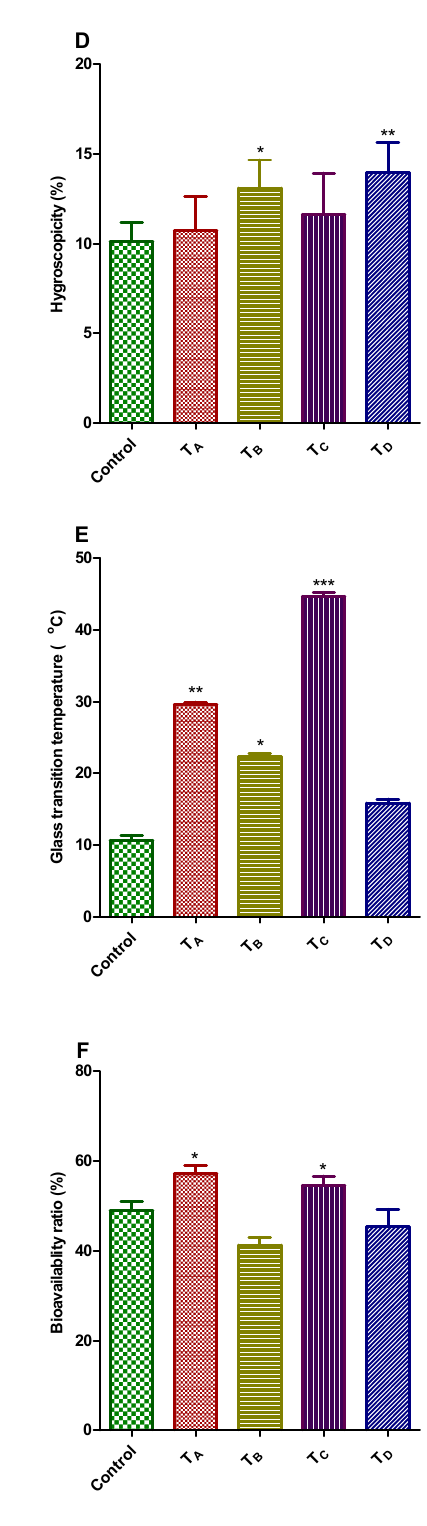
Figure 1. ( A – F ) Physical properties and bioavailability ratio (%) of PHF extract microencapsulated with GA, GE, MD and their combinations by freeze-drying method. Treatment A (T A ): Freeze-dried, with 5% GA & 5% GE; Treatment B (T B ): Freeze-dried, with 5% GA & 5% MD; Treatment C (T C ): Freeze-dried, with 10% GA; Treatment D (T D ): Freeze-dried, with 10% MD.